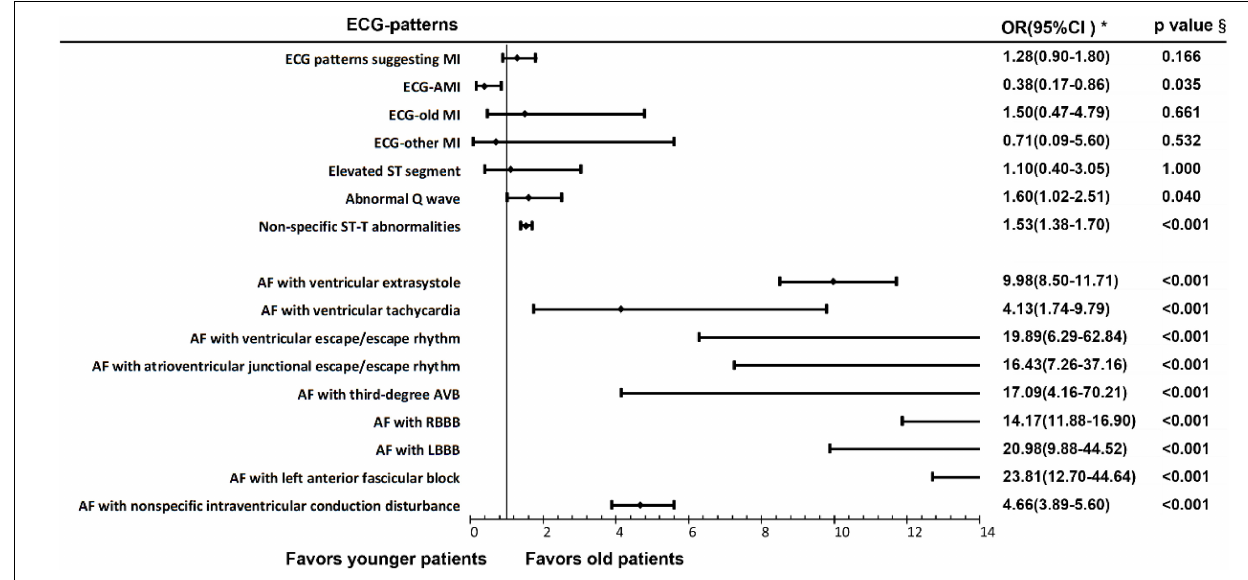
FIGURE 3 | Electrocardiogram patterns suggesting myocardial ischemia and arrhythmias in patients with AF of different age groups. § Chi-square test; *OR, odds ratio.